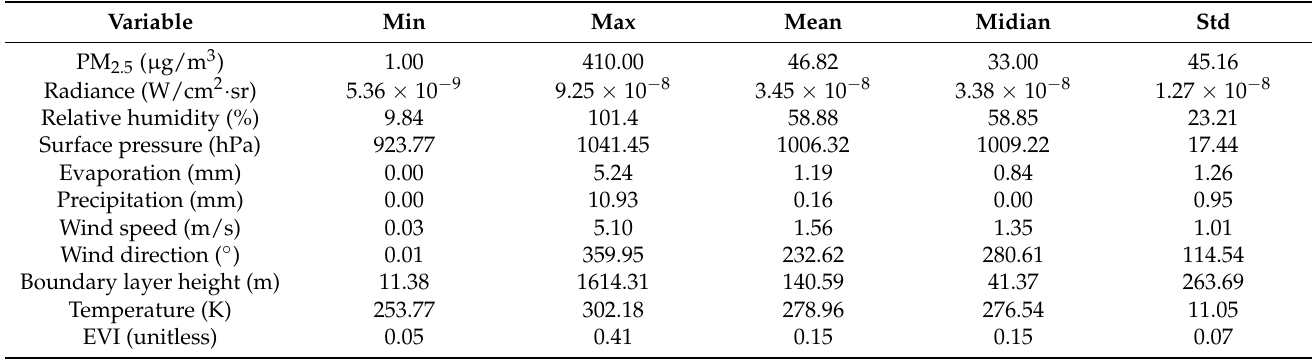
Figure 5. Histograms of variables in this study: ( a ) PM 2.5 ; ( b ) radiance; ( c ) relative humidity; ( d ) surface pressure; ( e ) evaporation; ( f ) precipitation; ( g ) wind speed; ( h ) wind direction; ( i ) bound- ary layer height; ( j ) temperature; ( k ) EVI. Table 6. Descriptive statistics for variables: Std is short for standard